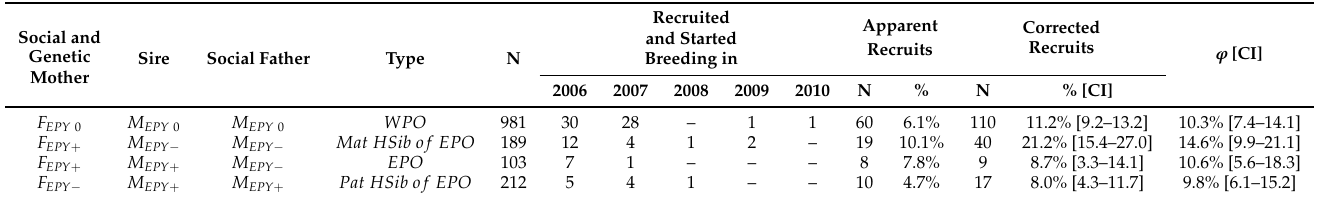
Table 1. The number of recruits and the recruitment rate of the fledglings related to the differences in genetic and social parents in the Western Siberian population of the European pied flycatcher.